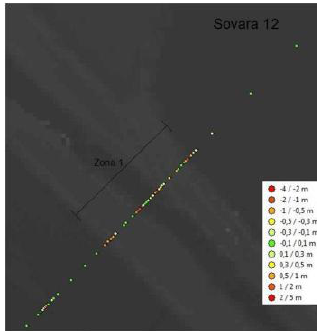
Figure 9. Distribution of the discrepancies between measured and interpolated height along the section surveyed The most critical cases were therefore